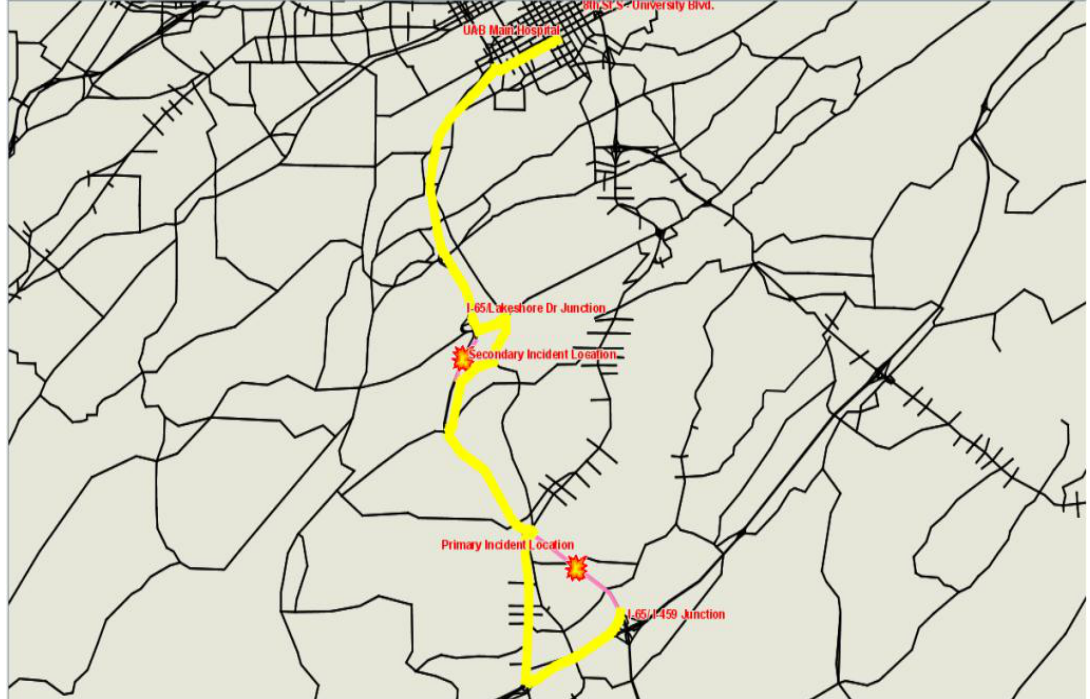
Figure 4. EMS vehicle’s path to UAB hospital with diversion in S3-22D.